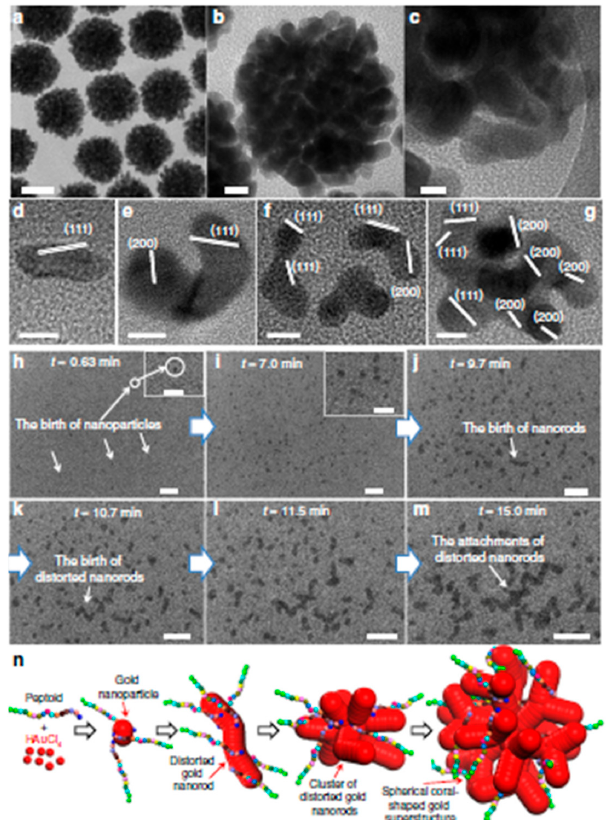
Figure 6. ( a , b ) TEM images of the coral-shaped nanoparticles (scale bar; ( a ) 50 nm; ( b ) 10 nm). ( c ) HR-TEM (scale bar, 5.0 nm). ( d – g ) HR-TEM images of distorted gold nanorods and clusters in early stages of coral-shaped particle formation (scale bar, 5.0 nm). ( h – m ) Sequence of in situ liquid cell TEM time (scale bar, 20 nm) showing the early stages of coral-shaped particle formation (insets of h, i are the magnification of TEM images, scale bar at 10 nm). ( n ) Schematic representation for the multibranched formation of gold nanoparticles induced by peptoids. Reproduced from [51] with permission from the Nature Publisher.